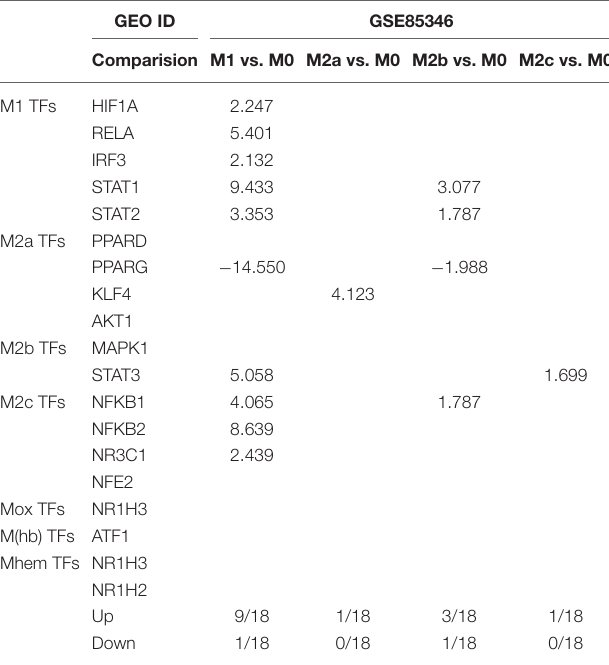
Table 1 . Of note, six genes overlapped in different bioenergetics metabolic pathways. Comparing the M ϕ from peritoneal